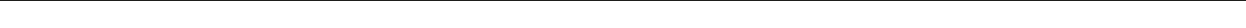
Fig. 4 ULK1 physically interacts with STX17. a , b , c Interaction between ULK1 and STX17 were determined using overexpression ( a ) and endogenous ( b , c ) proteins to perform IP assay followed by WB with indicated antibodies. d GST-ULK1 was cotransfected with GFP-STX17 fragments into HEK293T cells for 24 h. Pull down with glutathione beads was performed and analyzed with GFP antibody. e The GST-ULK1 truncations were transfected into HeLa cells for 24 h, and pull down with glutathione beads and analyzed with STX17 antibody. f GST-ULK1 279 – 525 and His-STX17 157 – 275 were puri fi ed from bacteria and incubated with glutathione beads for 4 h. After washing, the elution was analyzed with His antibody. g Myc-ULK1 or Myc vector was cotransfected with GFP-STX17 for 24 h. PLA assay was performed, and the signals (red) were detected under confocal microscopy. Scale bar, 10 μ m. h The mice were injected with GÖ6983 (22.0 μ g per mouse) or PBS for 7 days via tail vein. IP was performed of liver lysates with STX17 antibody. The IPs were detected by ULK1 antibody. The indicated antibodies were used to con fi rm drug ef fi ciency. i HeLa cells were transfected with GFP-STX17 and Myc- ULK1 for 24 h with/out serum starvation (S.S.). PLA assay was performed with Myc and GFP antibodies. The fl uorescence signal (red) was observed under confocal microscopy. Scale bar, 10 μ m. An average signal was quanti fi ed with a minimum of 20 cells and is shown in the right bottom panel. j The representative images of PLA assay of GFP-STX17 cotransfected with Myc-ULK1 WT, S423A, S423D, or Myc vector into HeLa cells for 24 h. Scale bar, 10 μ m. An average signal was quanti fi ed with a minimum of 20 cells and is shown in the left top panel. All values are means ± SEM of three independent experiments. Student ’ s t -test (unpaired); * p < 0.05, ** p < 0.01, *** p < 0.001. WCL: whole-cell